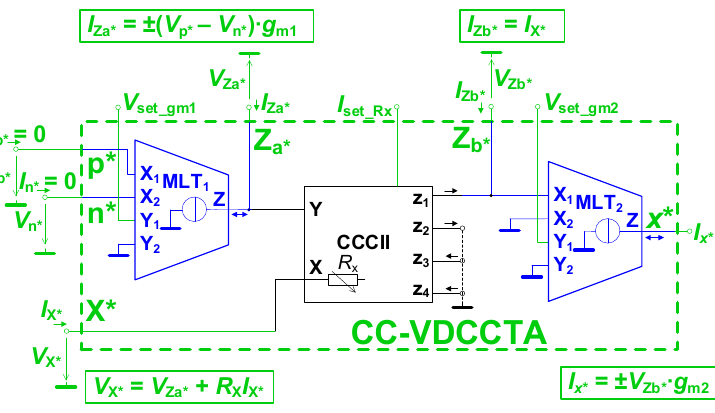
Figure 11. Example of the interconnection of three cells of the fabricated IC, defining an advanced active element (AE) with three adjustable parameters: a so-called current-controlled voltage differencing current conveyor transconductance amplifier (CC-VDCCTA).